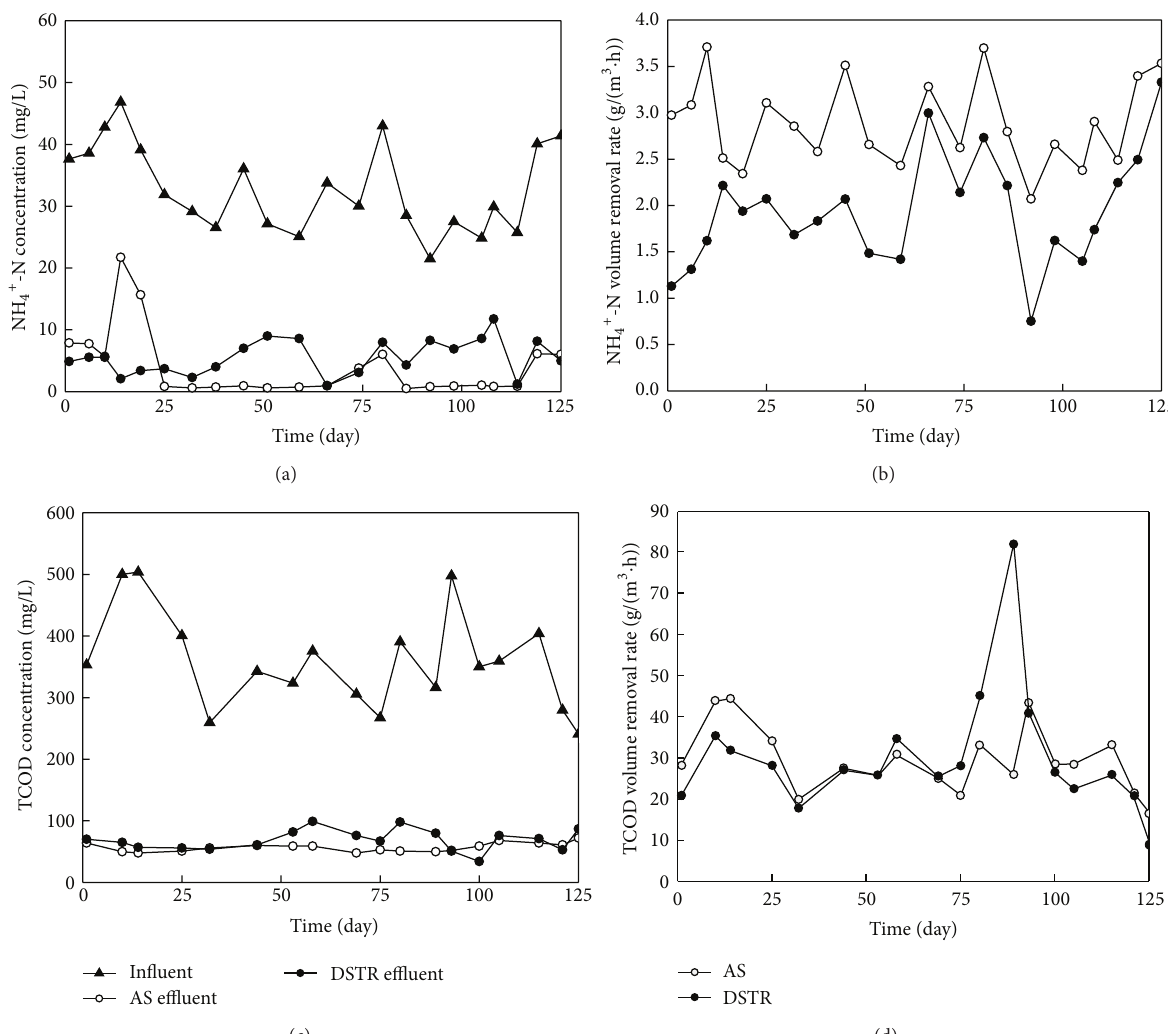
Figure 5: TCOD and NH 4+ -N removal in DSTR and AS reactors. (a) NH 4+ -N removal; (b) NH 4+ -N volume removal efficiency; (c) TCOD removal; (d) TCOD volume removal